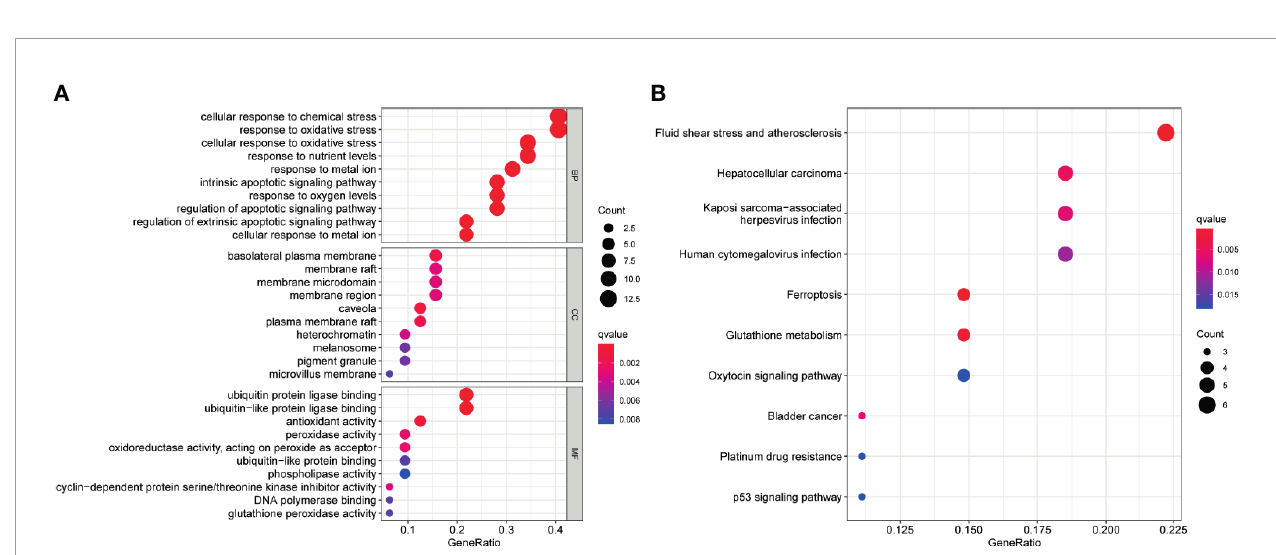
FIGURE 2 | Functional enrichment analysis of the 32 differentially expressed FRGs in TCGA-BLCA cohort. Top 10 enriched biological processes, molecular functions, cellular components (A) , and KEGG pathways (B) terms of 32 differentially expressed FRGs are shown in this study. FRG, ferroptosis − related gene; TCGA, The Cancer Genome Atlas; BLCA, bladder cancer; KEGG, Kyoto Encyclopedia of Genes and